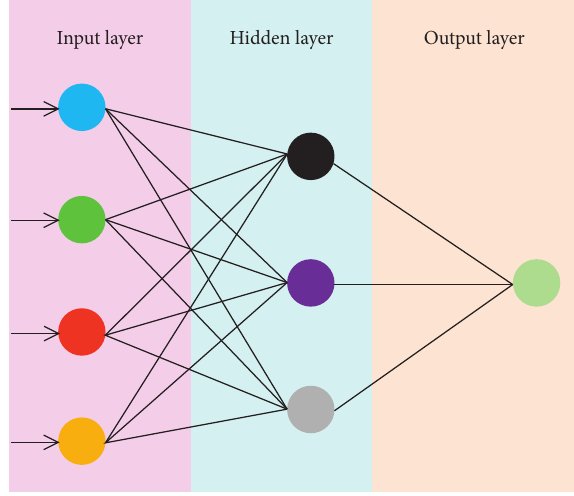
Figure 1: BP neural